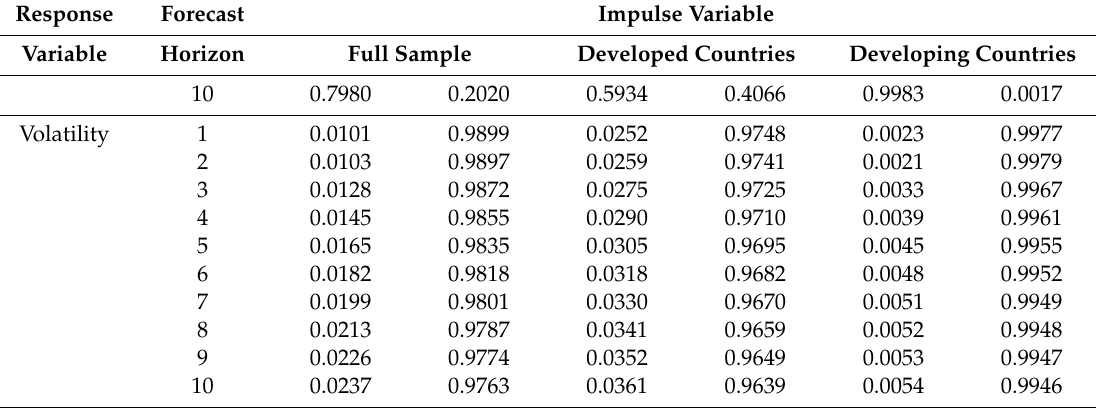
Table 3. Cont. Panel A: SVI and